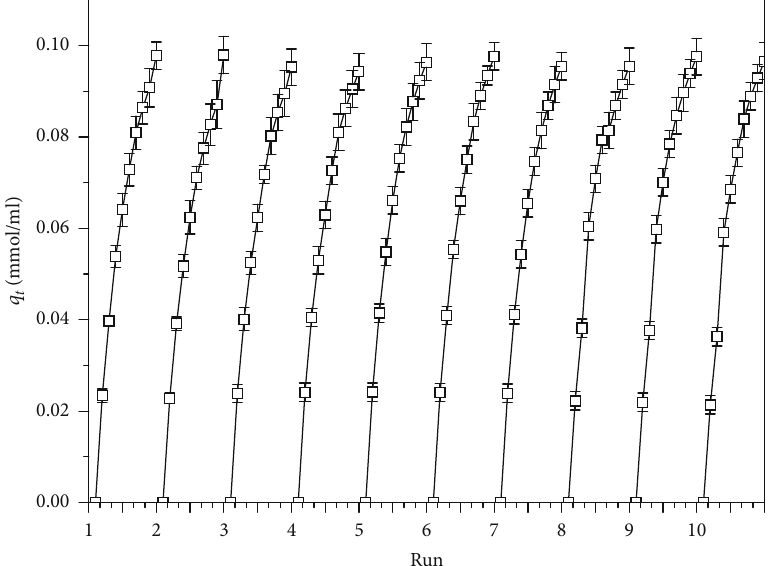
Figure 9: CO capture of CPEI sorbent slurry in the SBCR during adsorption/desorption cycles under the conditions of 0.025g/ml of the 2 sorbent fraction, 5mol % CO /N , 100 ml/min the gas fl ow rate at 30 ° C and 101.3kPa using 2 2